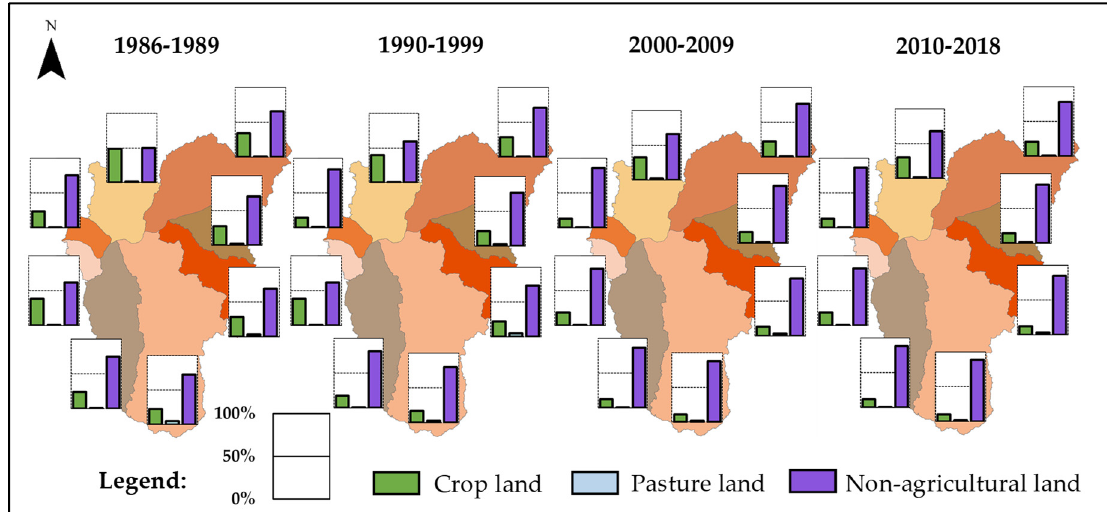
Figure 14. Percentage of land use by crops, pasture and non-agricultural areas.